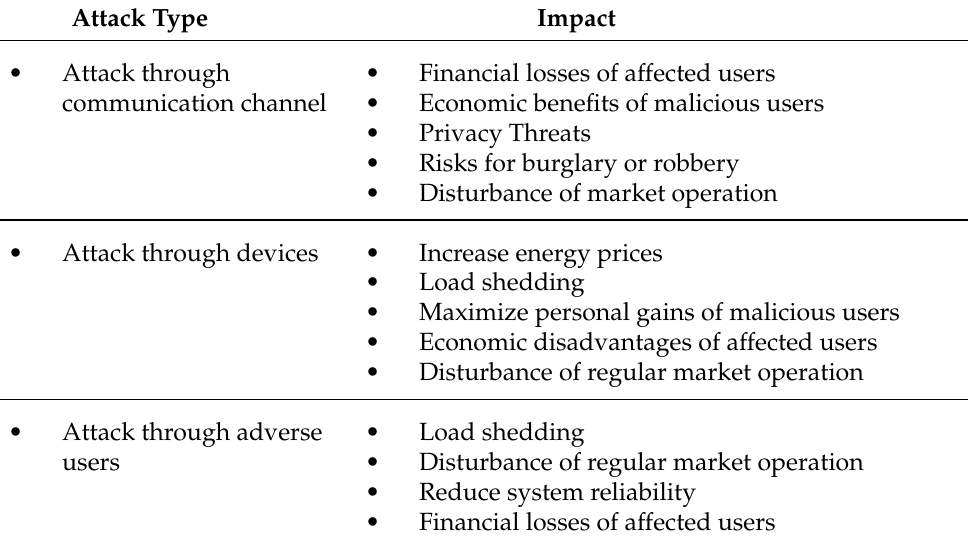
Table 3. Impact of Attacks in the Monash Microgrid